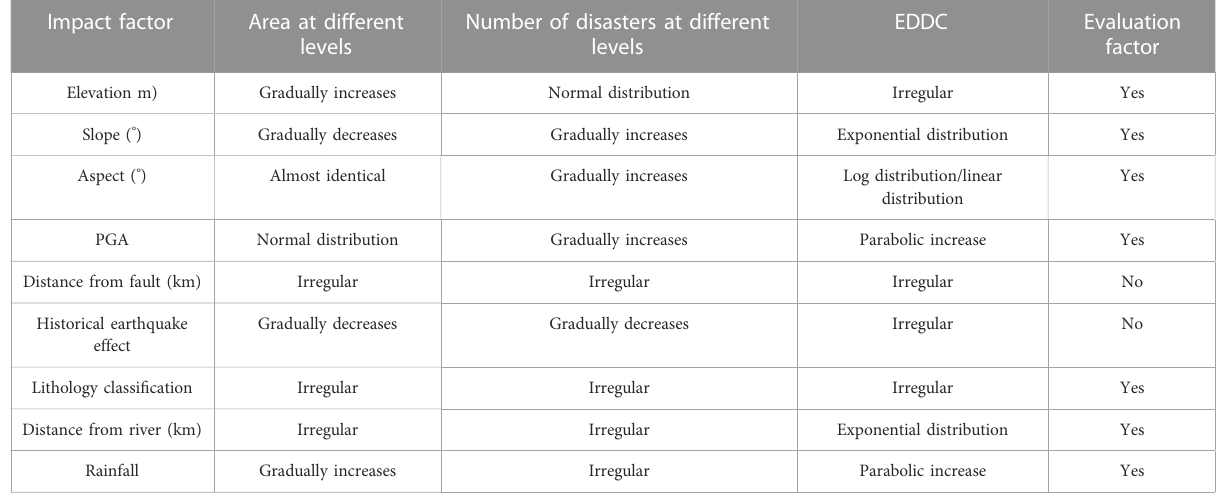
TABLE 5 Summary of the relationship between engineering disturbance disasters and in fl uencing factors. Impact